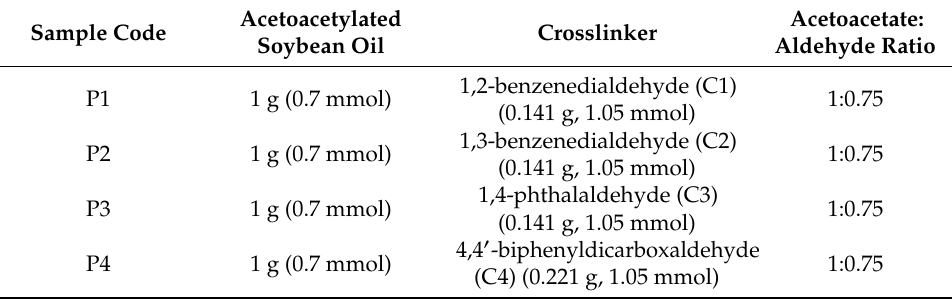
Table 1. Sample codes and ratios of materials in the Knoevenagel addition reaction.